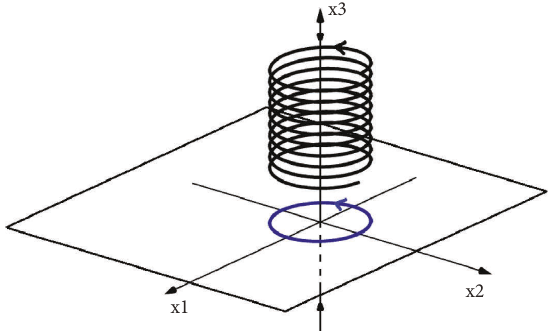
Figure 3: Qualitative behavior of the solutions when β > 1/ h . Table 1: Parameter values and initial and equilibrium values of model variables ( Δ � 0 ) .